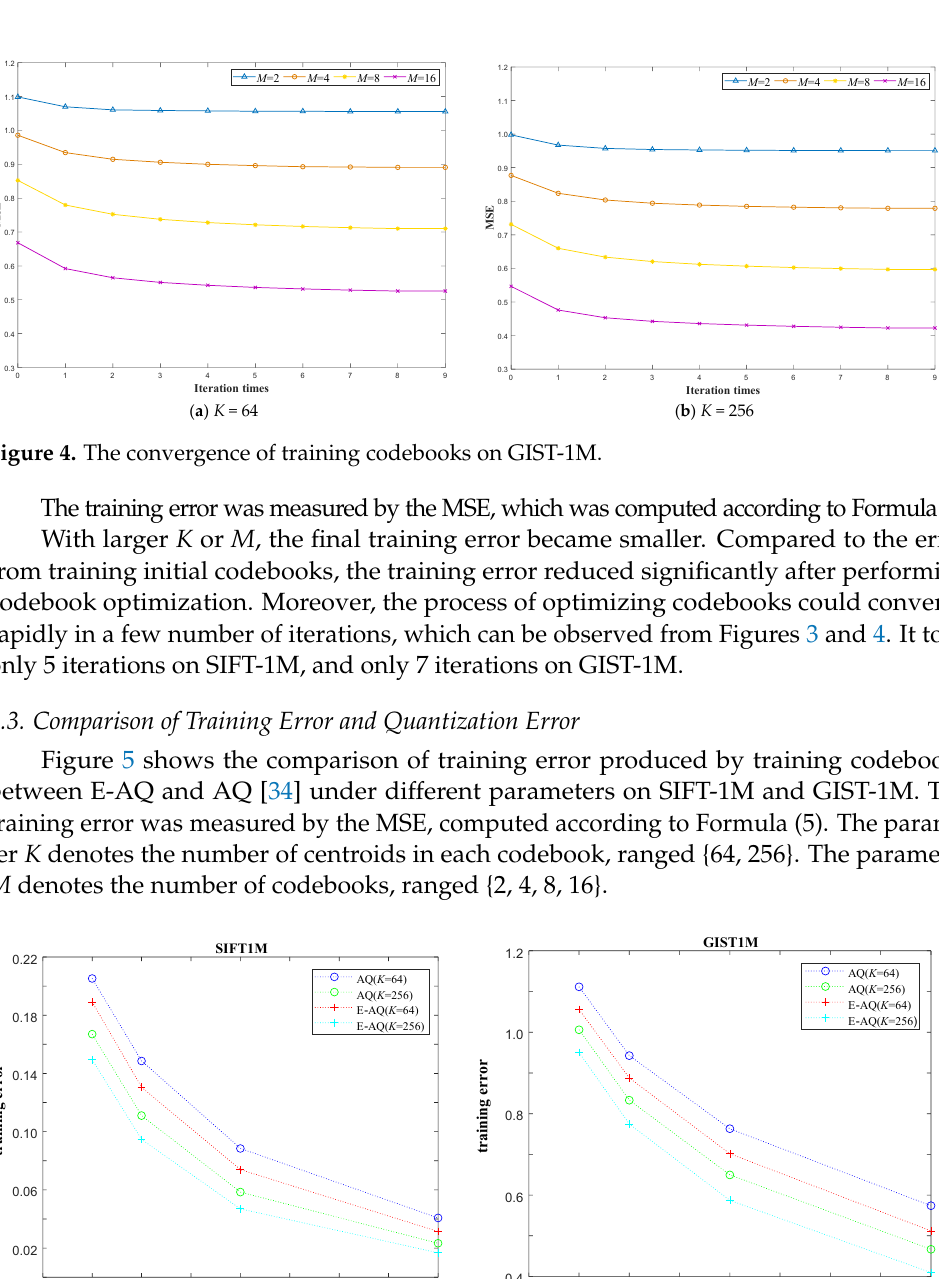
Figure 3. The convergence of training codebooks on SIFT-1M.